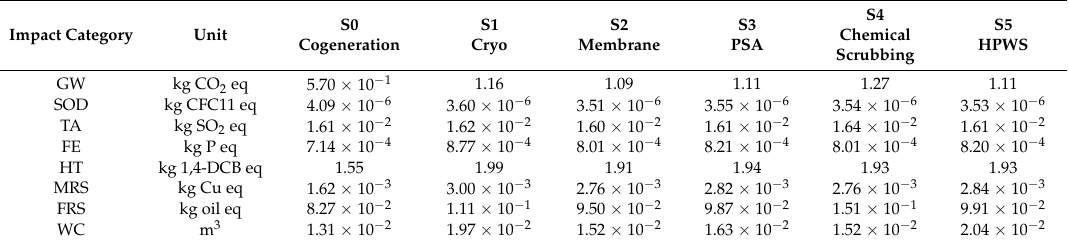
Table 2. ReCiPe Midpoint (H) characterized total impacts calculated for the different conversion routes of biogas, with reference to a functional unit of 1 m 3 of used biogas.